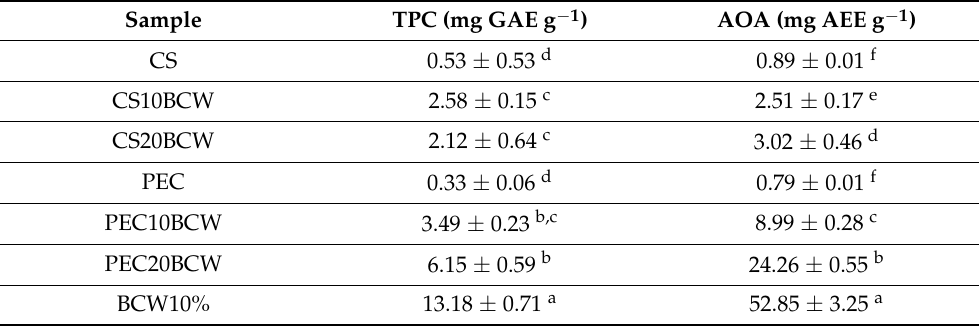
Table 5. Total phenolic content (TPC) and antioxidant activity (AOA) in PEC and CS films with different amounts of